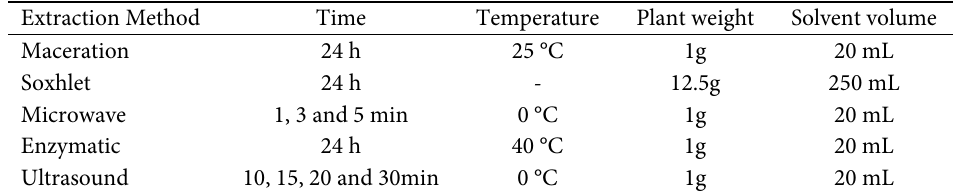
Table 1. Characterization of the extraction